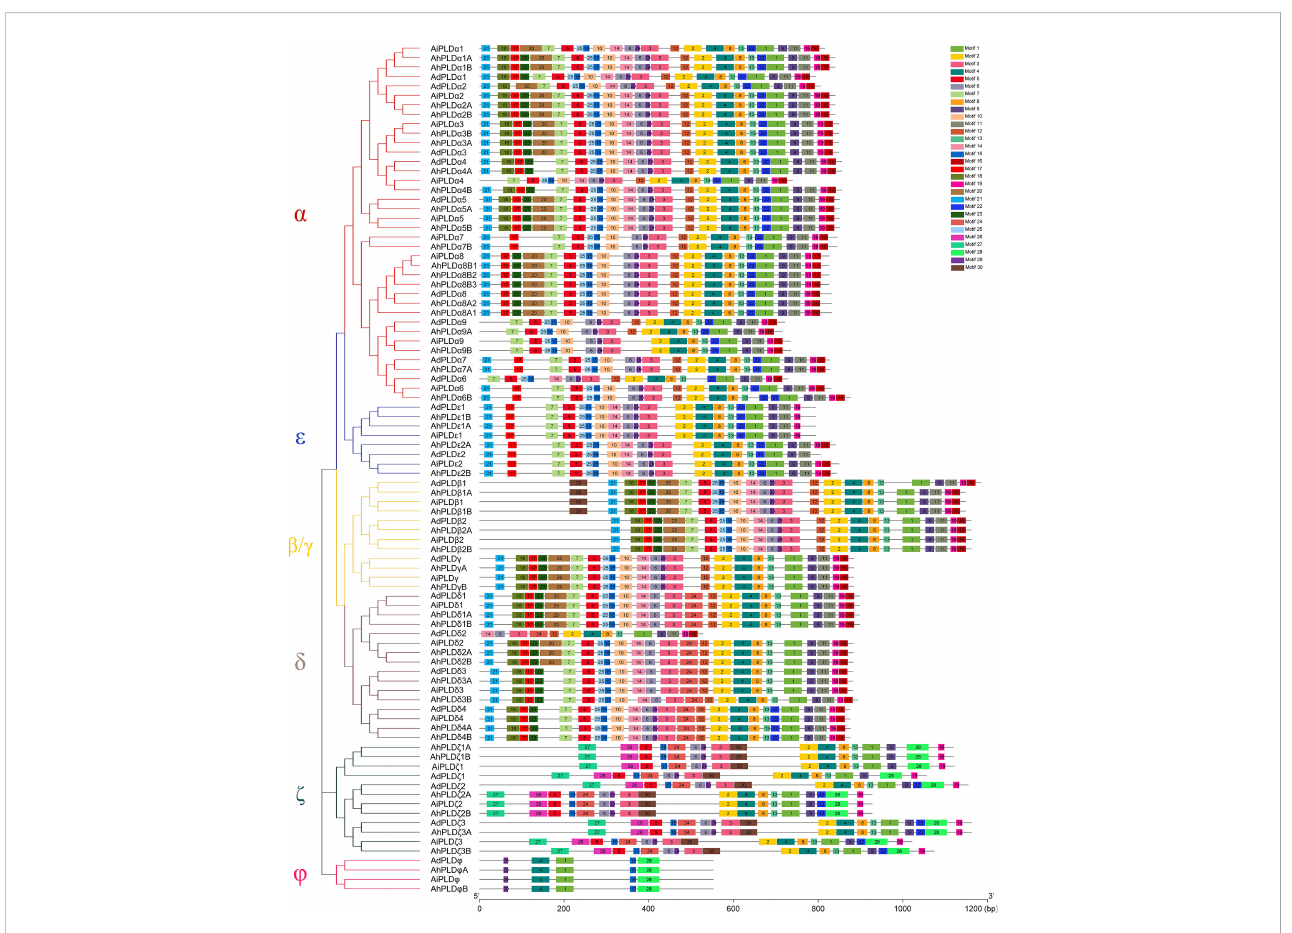
FIGURE 4 Motif composition of PLD proteins in peanut and its two progenitors. The red, blue, yellow, purple, dark green and pink branches on phylogenetic tree represent the a , e , b / g , d , z and f isoforms, respectively. The motifs, numbers 1-30, are displayed in different colored boxes.